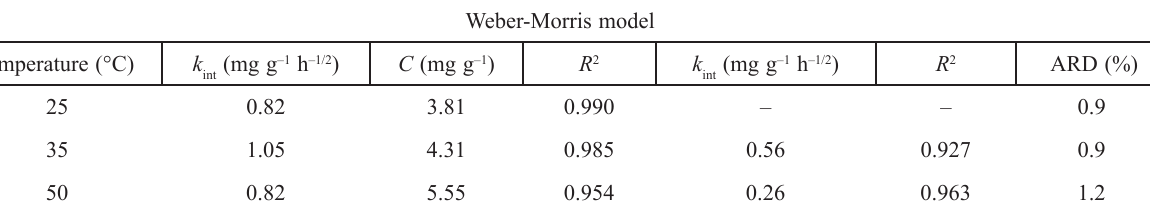
Table 5 – Weber-Morris and film diffusion mass transfer rate kinetic model parameters for cefdinir adsorption on TiO adsorption temperatures (C